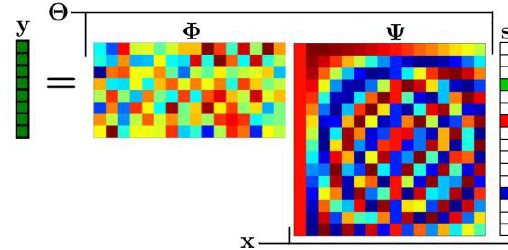
Figure 1. Graphical schematic of the basic compressed sensing